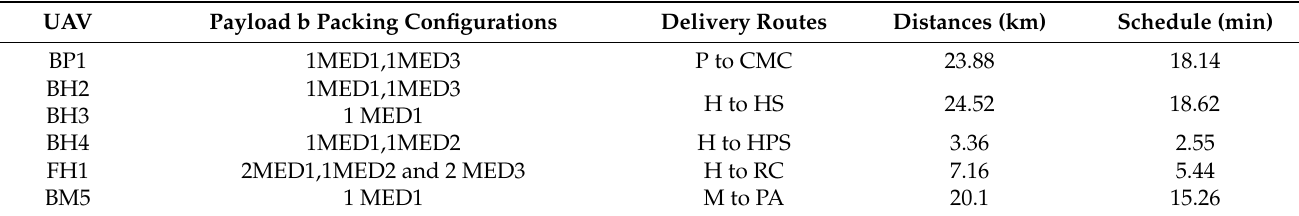
Table 9. The calculation of traffic planning model based on shortest